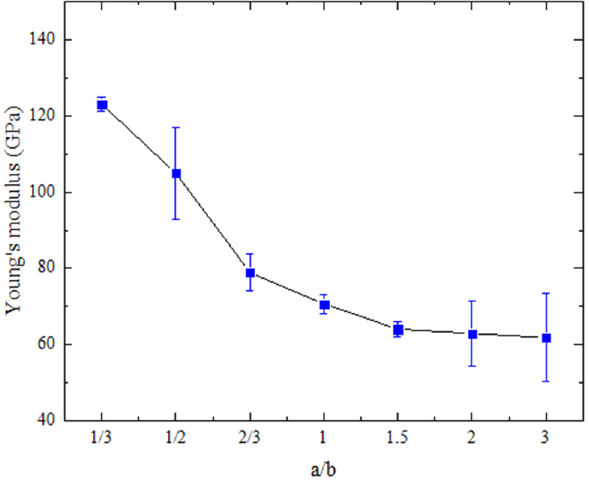
Figure 10: Curve of Young ’ s modulus versus a/b value ( stretched in the x - direction )